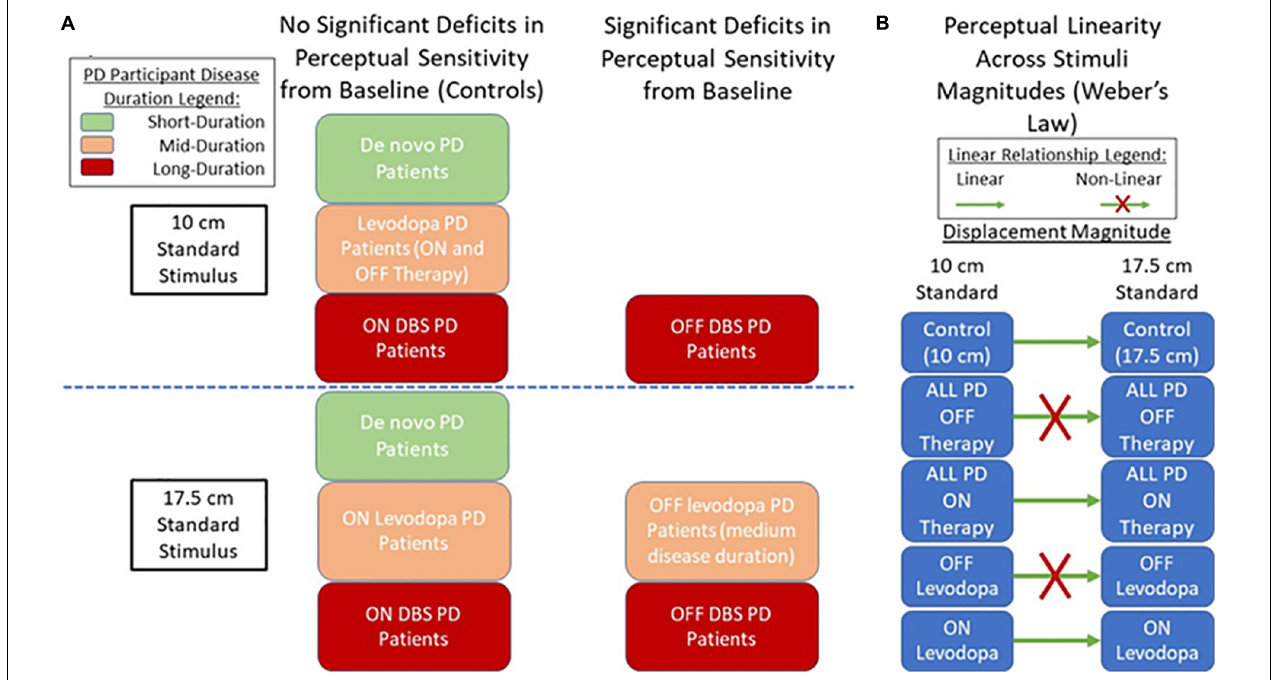
FIGURE 4 | Displacement Perception in PD Summary. (A) Findings on displacement perception sensitivity between PD patient groups compared to control (baseline) participants. (B) Findings on the state of perceptual linearity according to Weber’s